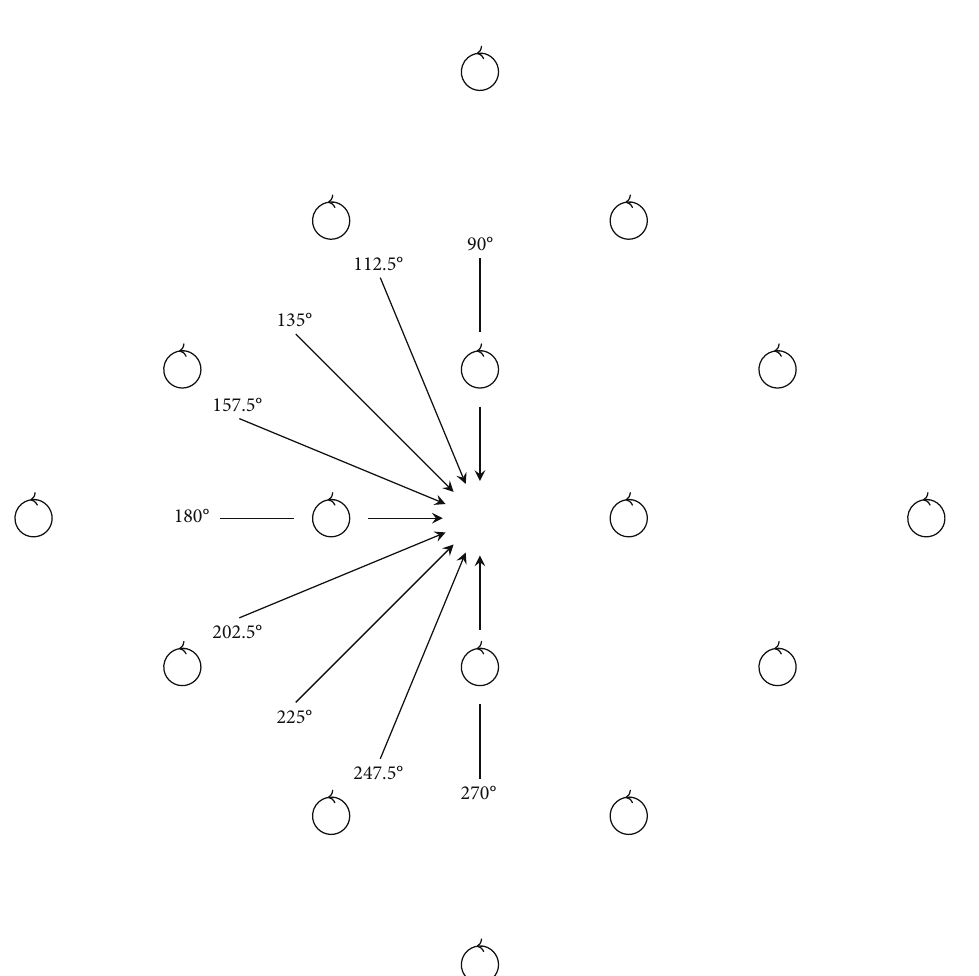
Figure 6: Wind directions that will be used in the current study. Only half the entire sector will be used due to symmetry. Table 3: Wind data at 40m from Bockstigen, Gotland, Sweden. Turbulence intensity according to wind